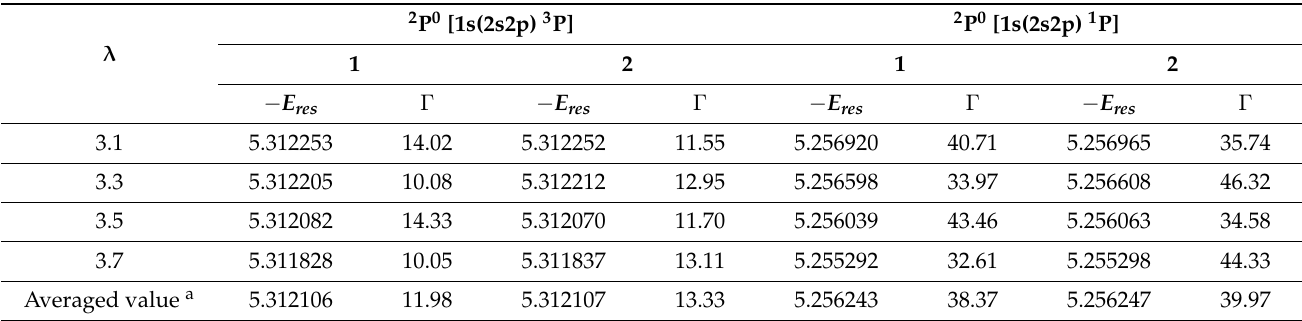
Table 6. Energy (a.u.) and width ( × 10 − 5 a.u.) of the first and the second 2 P 0 resonant states of Li atom calculated by stabilization method (1) and CAP (2). For CAP, the results were obtained by method A.